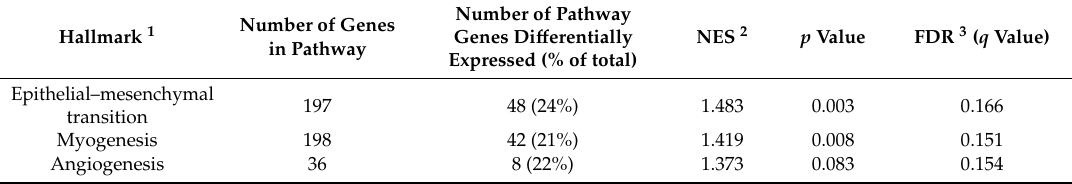
Table 2. The Gene Set Enrichment Analysis (GSEA) for hallmarks enriched in HMGA2-overexpressing DLD-1 cells.